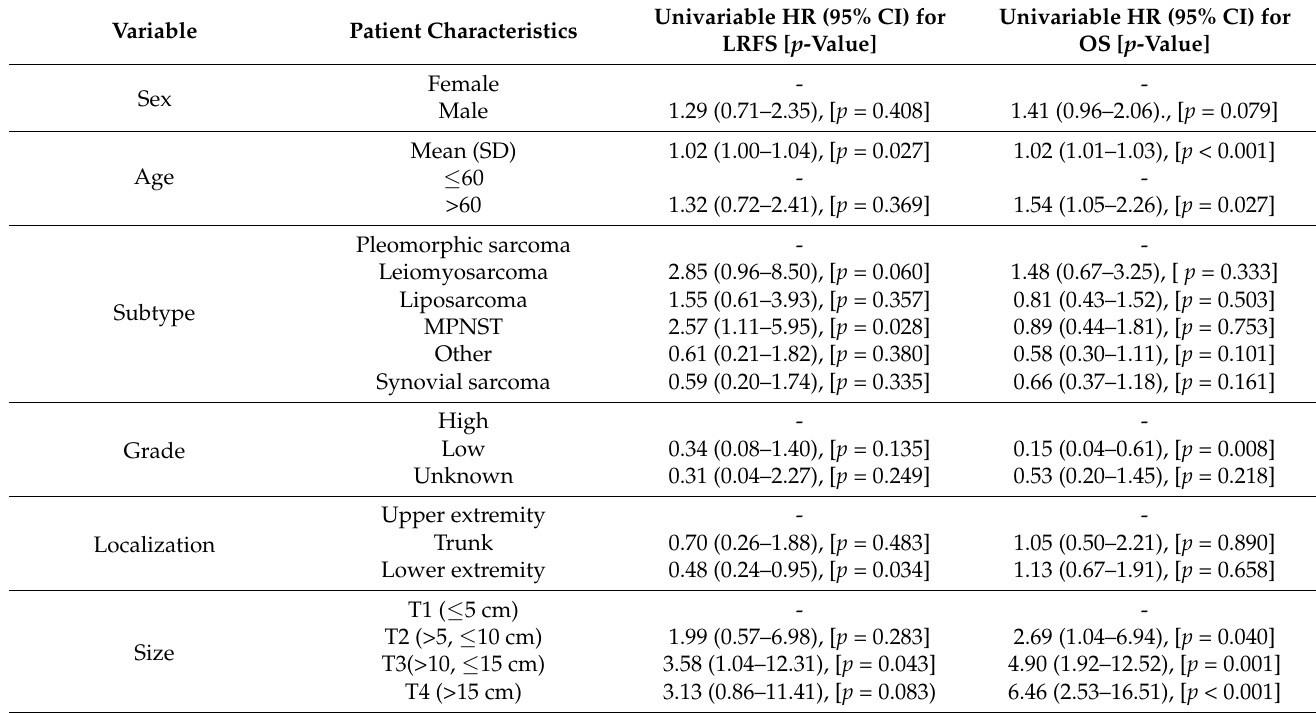
Figure 1. Factors having an impact on LRFS: ( A1 ) resection margin, ( A2 ) tumor subtype and OS: ( B1 ) tumor size, and Figure 1 . Factors having an impact on LRFS: (A1) resection margin (A2) tumor subtype and OS (B1) tumor size ( B2 ) tumor grade. (B2) tumor grade Table 3. Factors affecting the LRFS and